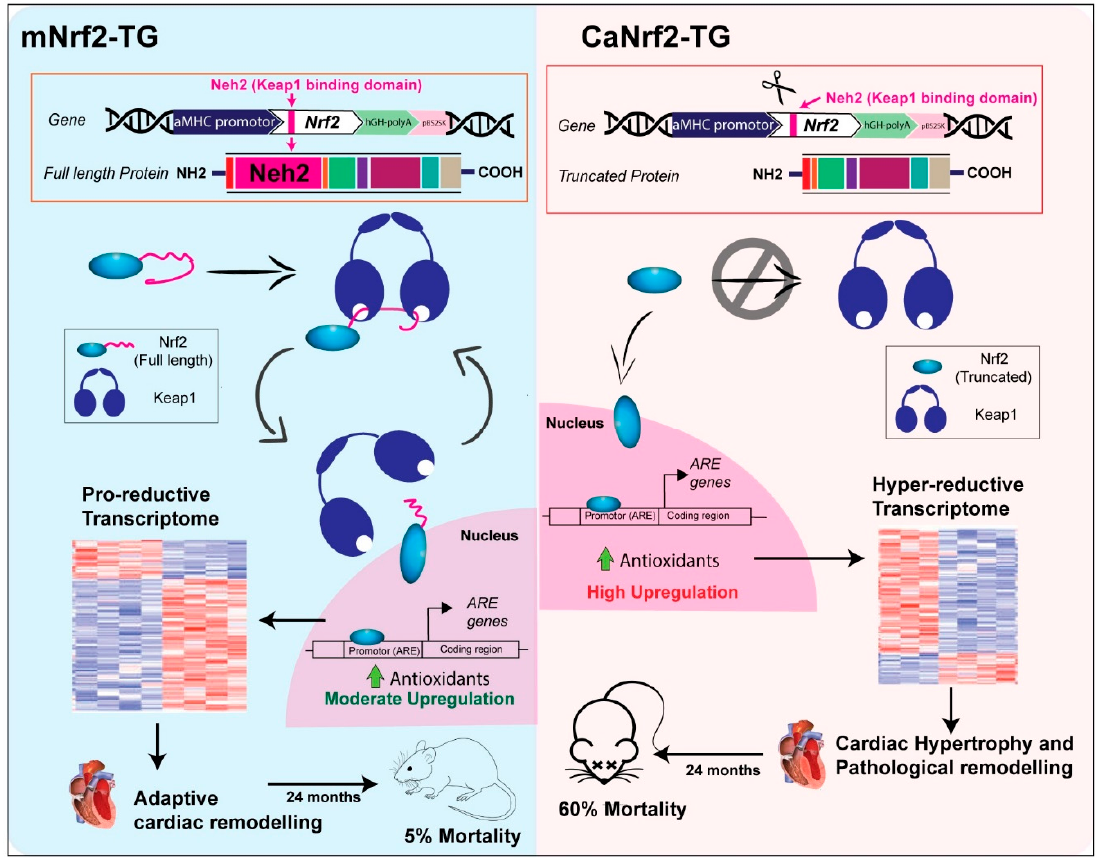
Figure 5. Enhanced Nrf2-Keap1 signalling generates excess Nrf2 at baseline without affecting keap-1 interaction, results in moderate antioxidant upregulation leading to a pro-reductive transcriptome. This leads to an adaptive cardiac remodelling without affecting survival in mNrf2-TG mice. Whereas, affecting the Nrf2-Keap1 signalling renders Nrf2 to be constitutively active. This results in high upregulation of antioxidants that consequentially affect cardiac structure and function resulting in increased mortality rate at 6 months in